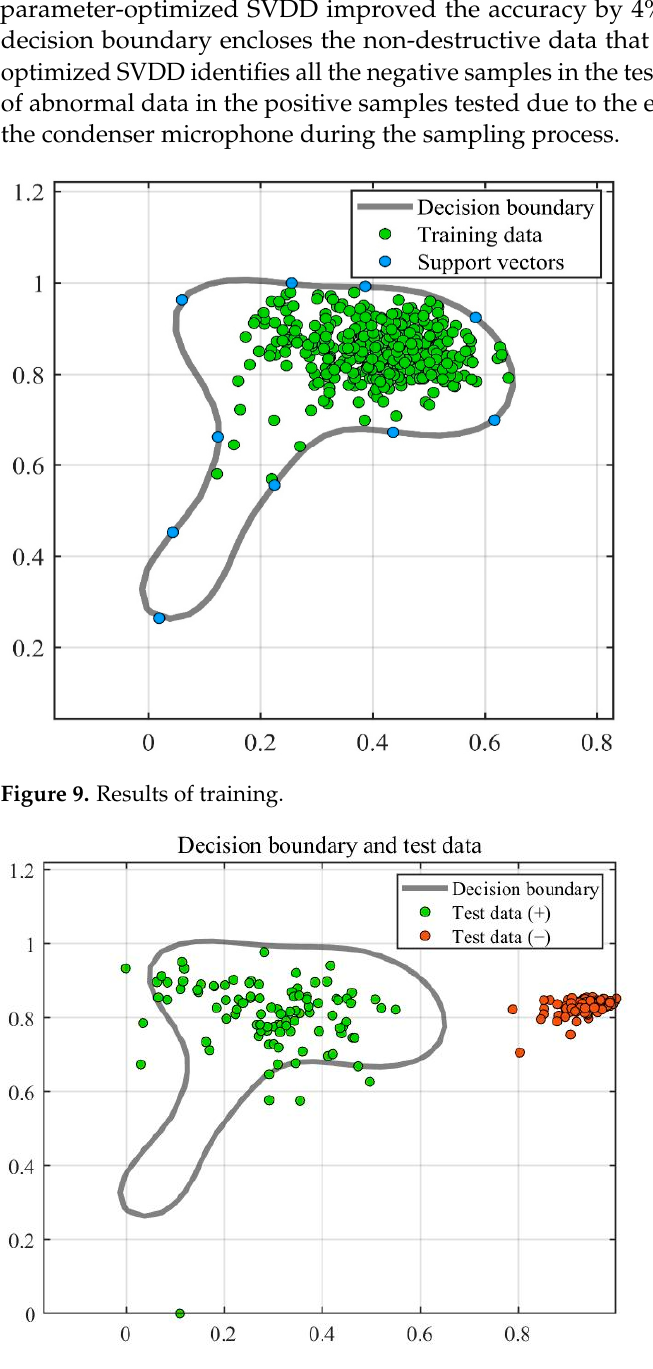
Figure 11. Identifying the results of damage. In SVDD, the choice of parameters determines the accuracy of the model. PSO has the advantages of fast convergence, few parameters, and a simple algorithm. The GA is fl exible enough to solve a variety of complex optimization problems with high computa- tional e ffi ciency and can solve optimization problems in any dimension. BO is computa- tionally e ffi cient by building a probabilistic model from the past evaluation results of the